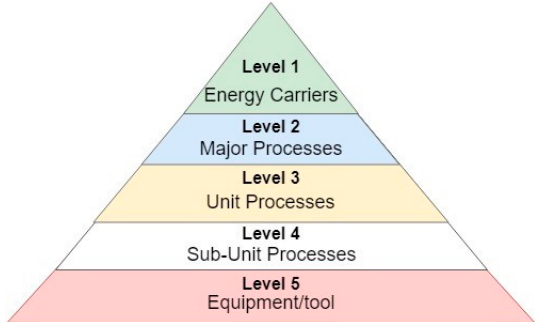
Figure 4. Hierarchical classification of the taxon for energy use.